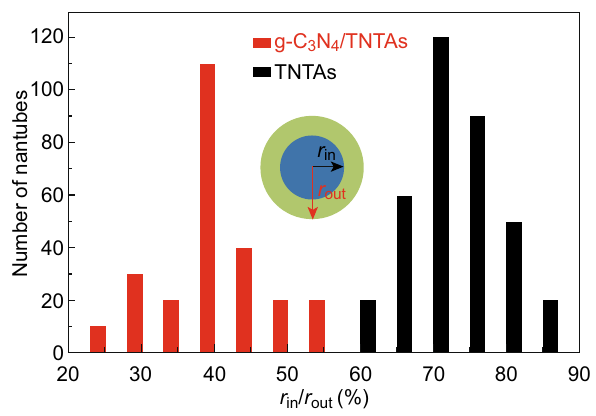
Fig. 4 Number of nanotubes with different r in / r out values for TNTAs (black) and g-C 3 N 4 /TNTAs (red). (Color figure online)